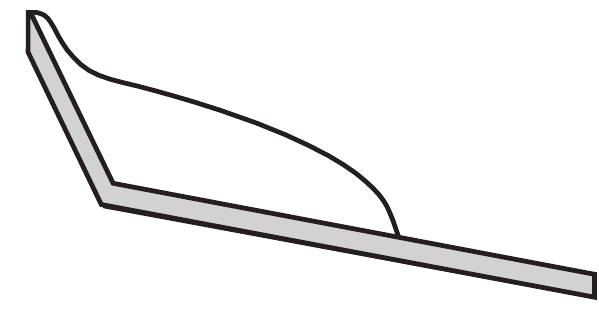
Fig. 1. Schematic view of the glacier considered in the two-layer model. The ice body (white) resides on a sediment layer (grey) which extends into the glacier forefield. The inclination of the upper part is 45 ◦ and of 5 ◦ for the lower part.